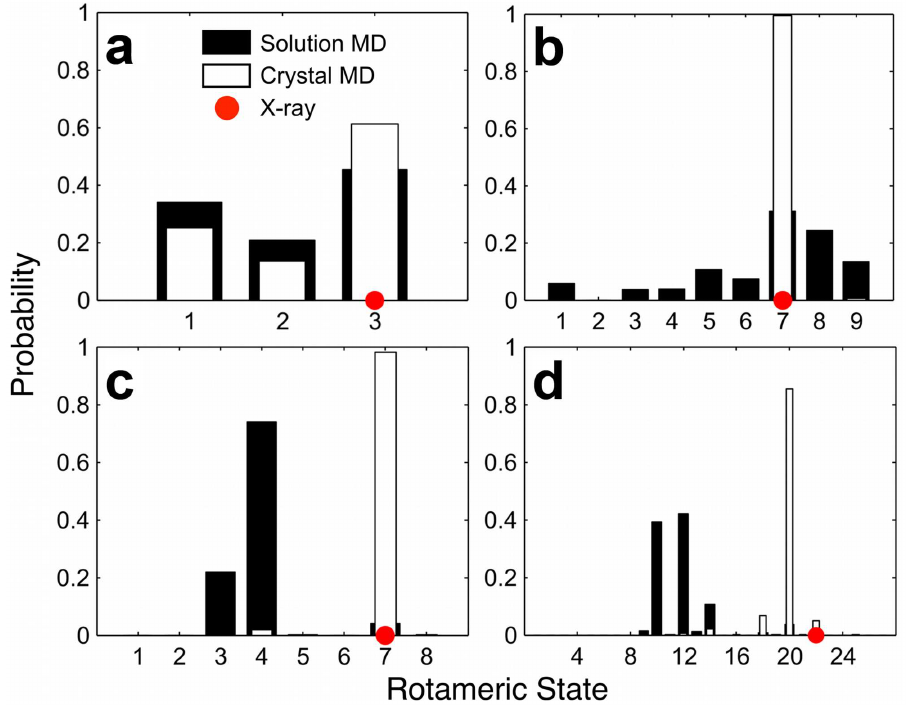
Fig 2. Representative rotamer probability distributions for severalresidues in CVN. Rotameric states are denotedby numberson the horizontalaxis, and correspond to the order in which they appearin the Penultimate Rotamer Library [26] for each residue. (a) Leu69 in chain B (B:Leu69)does not participatein a crystal contact and exhibits high conformational overlapbetweenthe distributionsobtainedfrom solution (black bars) and crystal (white bars) MD simulation( OC = 0.83), roughlyno change in conformational entropy ( T Δ S conf = –0.10 kcal/mol), and agreementbetweenthe rotamer observedin the X-ray structure (denotedby the red dot) and the most dominant rotamer sampledin both simulations. (b) A:Gln6 participatesin a crystal contact and shows an OC = 0.32 and T Δ S conf = –1.06 kcal/mol, whilethe dominantrotamer agrees amongthe X-ray data and both simulations. (c) A:Glu56 is contactingand exhibits an OC = 0.06 and T Δ S conf = –0.36 kcal/mol, and the X-ray conformation agrees with crystal MD. (d) B:Lys74 is non-contacting and displaysan OC = 0.08 and T Δ S conf = –0.44 kcal/mol, and the dominant rotameric states and X-ray conformation